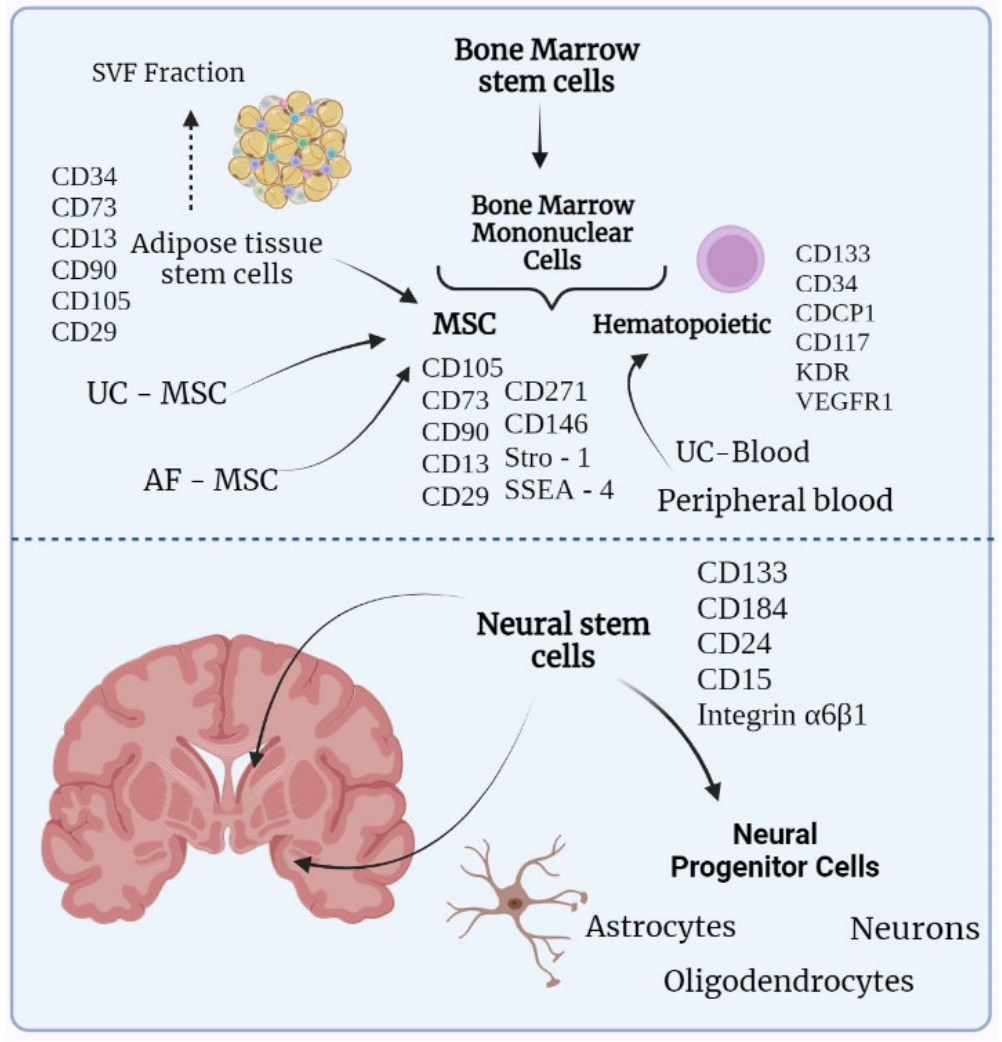
Figure 1. Various types of stem cells and their possible origins. This figure is presented for a general understanding of the possible sources of stem cells and is therefore greatly simplified. More detailed classifications can be found in the following papers [17–20]. Additionally, markers were indicated for some stem cells, the presence of which makes it possible to isolate certain cells. It is worth noting that the classification by surface markers includes more criteria, including the absence of certain markers. In turn, surface proteins can vary significantly. For example, in UC-MSCs there is no CD271, but there is CD146, which is also present on mesenchymal cells of the bone marrow and adipose tissue. Stro-1 , like SSEA-4 , was found only in MSCs from the bone marrow. For a more detailed description of the features of surface markers, we propose the following works [21–25]. In general, mesenchymal stem cells can be derived from a variety of tissues including bone marrow, adipose tissue, amniotic fluid, and umbilical cord. While all cells from these origins would be considered as mesenchymal, they would still differ in some properties such as immunosuppressive function. Hematopoietic stem cells are found in bone marrow, umbilical cord blood, and also in peripheral blood. The lower part of the figure contains an illustration of neural stem cells, originally deriving from the subventricular zone and the dentate gyrus of hippocampus. Neural stem cells are able to differentiate into oligodendrocytes, astrocytes, and neurons. Arrows are indicating the exact parts of the brain where neural stem cells are thought to be located. AF-MSC—amniotic fluid mesenchymal stem cells, UC-MSC—umbilical cord mesenchymal stem cells, SVF fraction—stromal vascular fraction, MSC—mesenchymal stem cells, UC-Blood—umbilical cord blood, VEGFR2 - vascular endothelial growth factor receptor